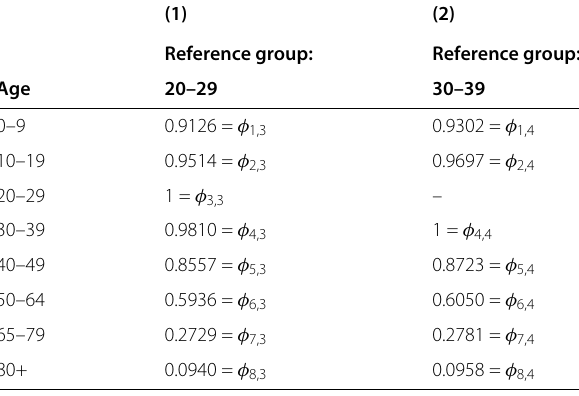
Table 5 Normalization coefficients by age